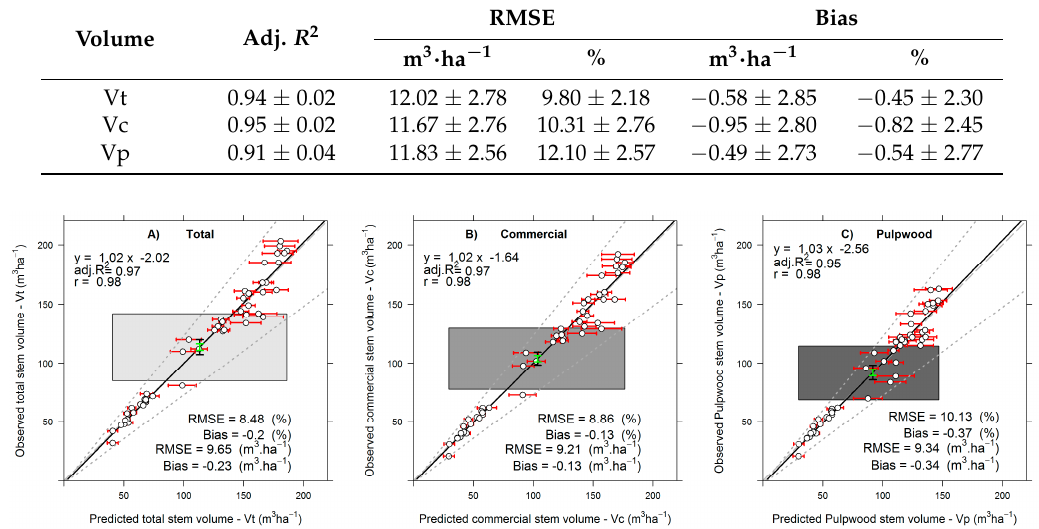
Figure 5. Equivalence plots of the observed and the mean of predicted Vt ( A ), Vc ( B ) and Vp ( C ) obtained from the 500 bootstrapped RF model runs. ( N = 50). The equivalence plot design presented herein is an adaptation of the original equivalence plots presented by [41]. The grey polygon represents the ±25% region of equivalence for the intercept, and the green vertical bar represents a 95% of confidence interval for the intercept. The predicted stem volumes from the RF models are equivalent with reference to the intercept and slope since the green bar is completely within the grey polygon. If the grey polygon is lower than the green vertical bar, the predicted stem volumes are negatively biased; and if it is higher than the green vertical bar, the predicted stem volumes are positively biased. Moreover, the grey dashed line represents the ±25% region of equivalence for the slope, the fit line is within the dotted lines and the black vertical bar is within the gray rectangle, indicating that the pairwise measurements are equivalent. A green bar that is wider than the region outlined by the grey dashed lines indicates highly variable predictions. The white dots are the pairwise measurements, and the solid line is a best-fit linear model for the pairwise measurements. The light grey dashed line represented the relationship 1:1. The horizontal red bars represent the standard deviation of the 500 bootstraping predictions.